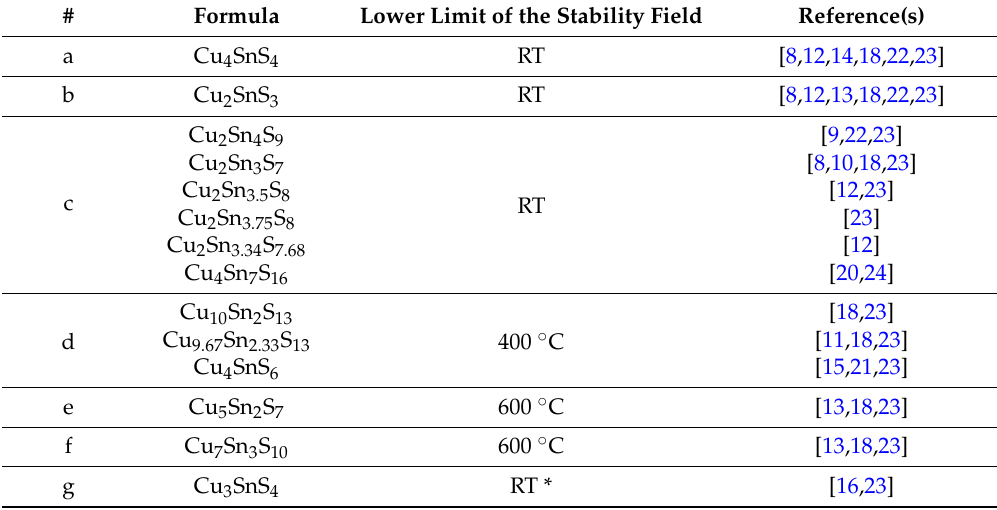
Table 1. Phases of the Cu–Sn–S system described in the